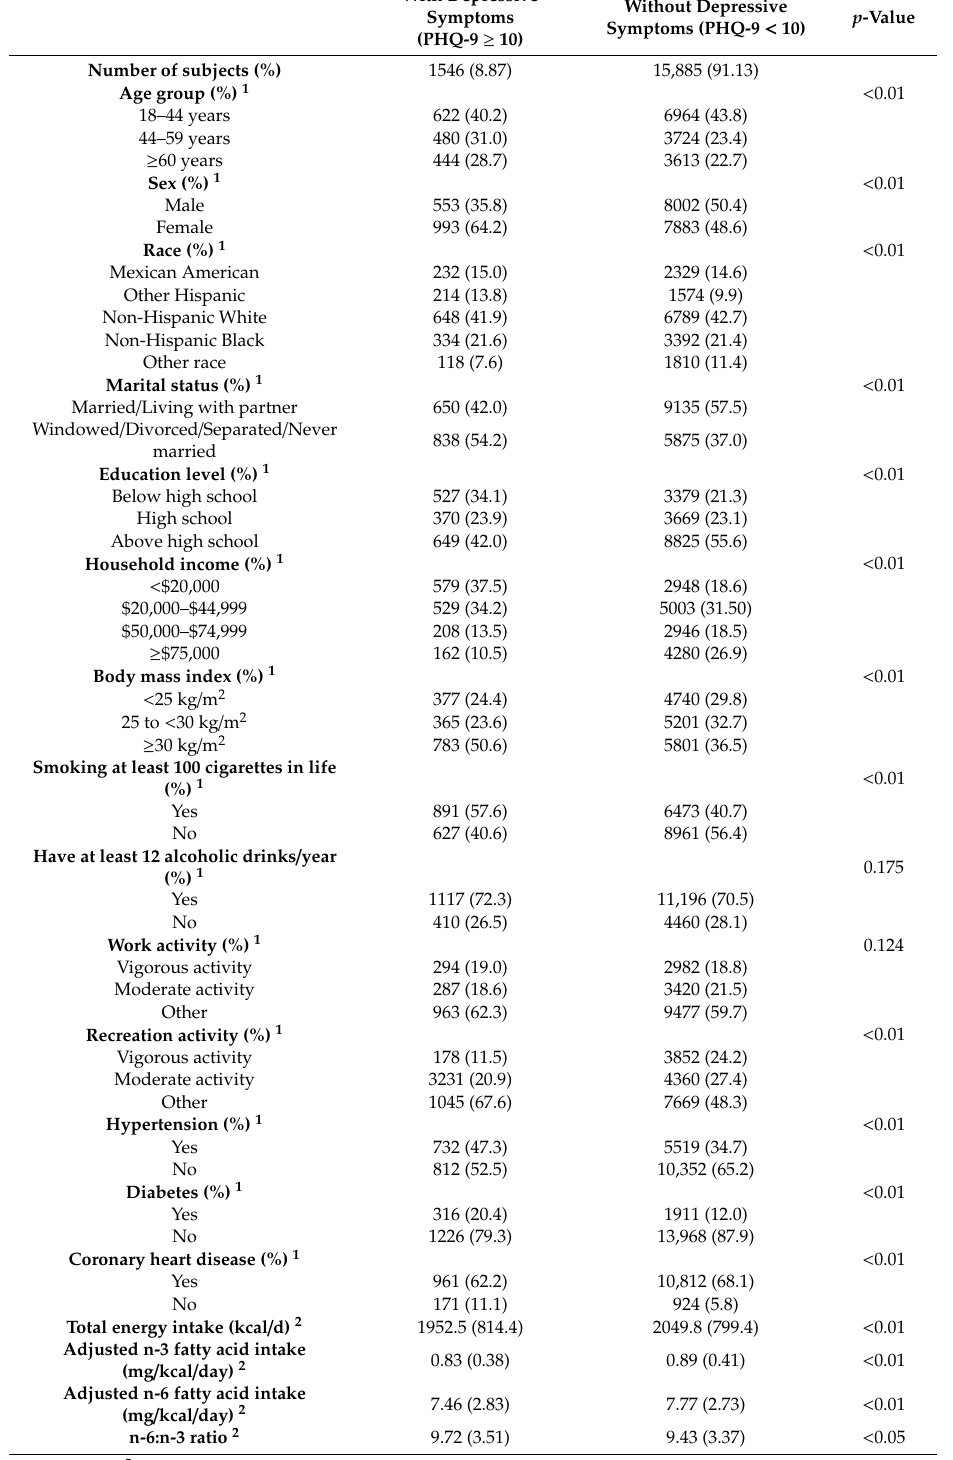
Table 1. Characteristics of National Health and Nutrition Examination Survey (NHANES) participants by depressive